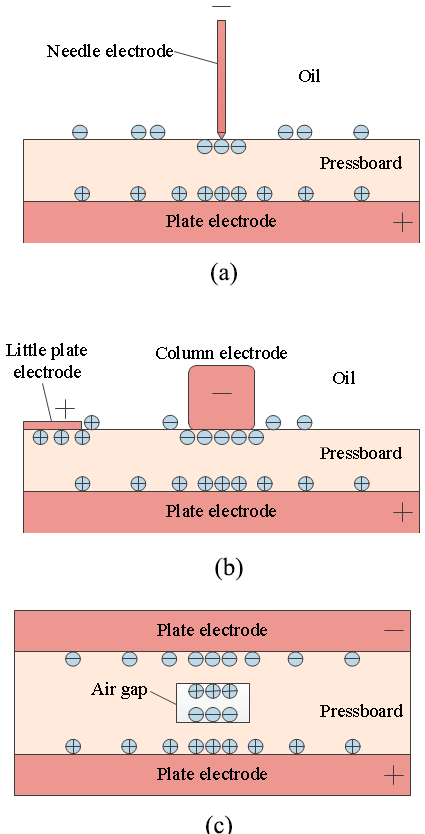
Figure 8. Space charge distribution diagram under DC component. ( a ) Needle-plate; ( b ) Surface discharge; ( c ) Air